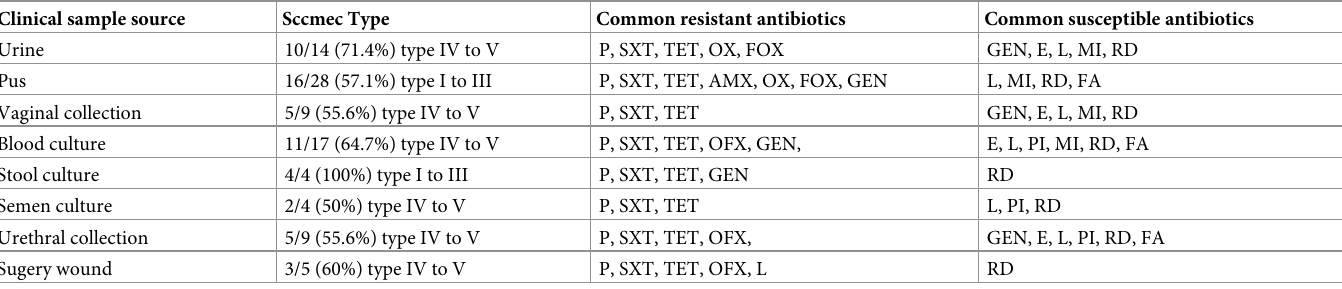
Table 8. Correlation of clinical sources, and antimicrobial resistance profiles. Clinical sample